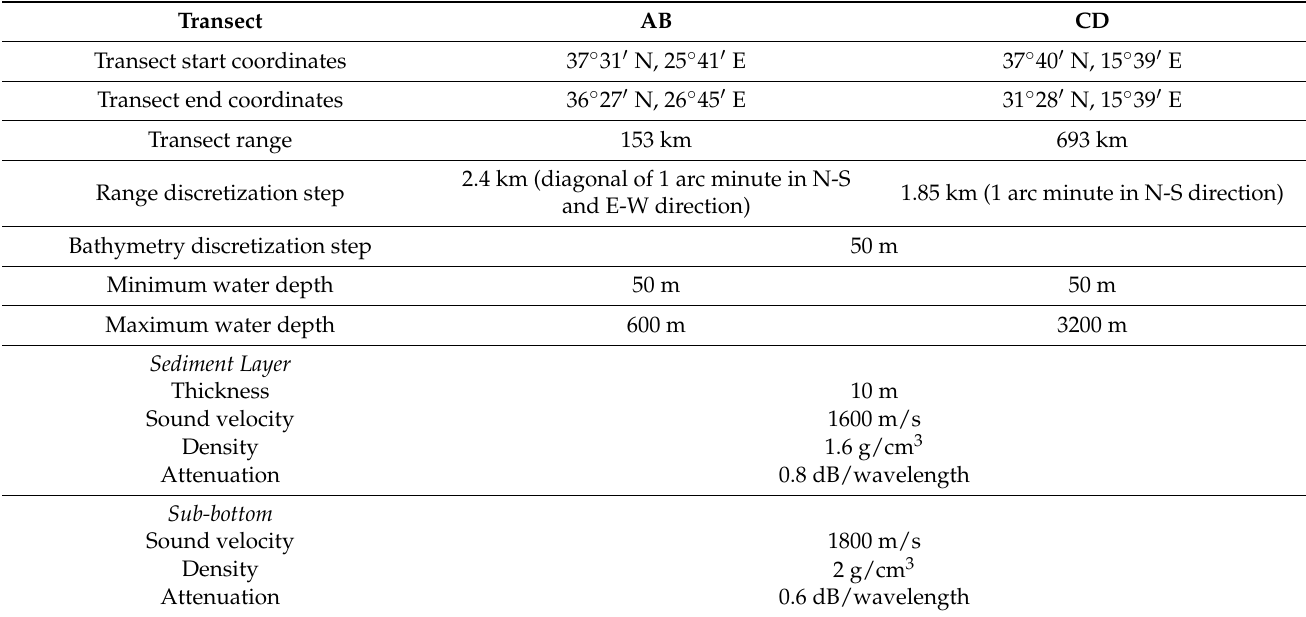
Figure 3. Bathymetry in the Eastern Mediterranean Sea. Transects A,B and C,D are used for comparisons of propagation calculations. Table 1. Characteristics of transects AB and CD.